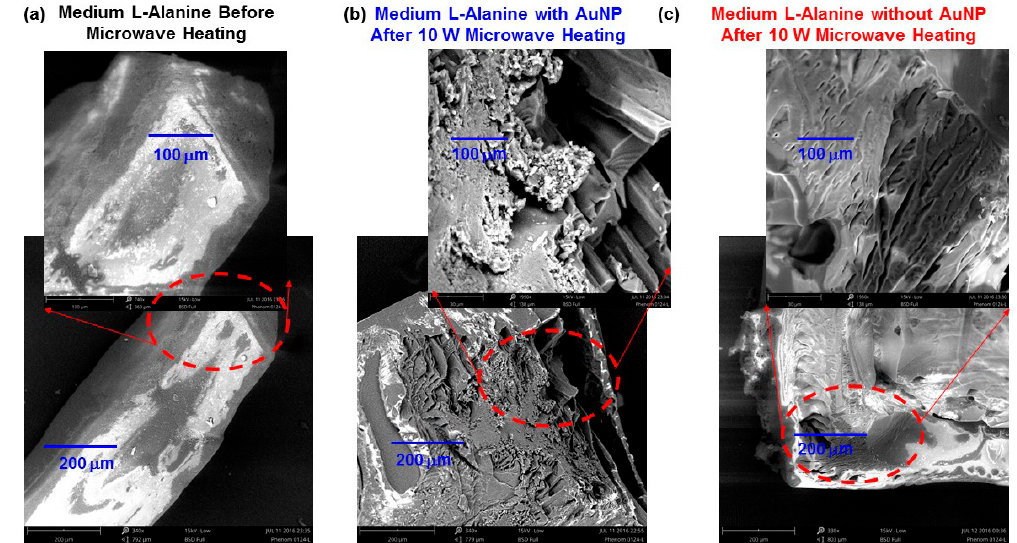
Figure 5. SEM images of medium L -alanine crystals ( a ) before and ( b ) after microwave heating for 120 s in the presence of gold nanoparticles (i.e., the MAMAD technique) and ( c ) after microwave heating in the absence of gold nanoparticles (control) at 10 W. Scale bars are200 μ m (large image) and 100 μ m (small image).